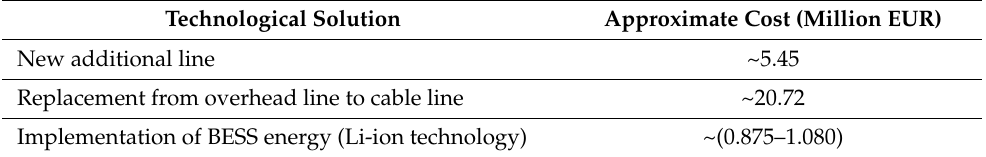
Table 18. Comparison cost of implementation or replacement of a 110 kV line with implemented BESS. Technological